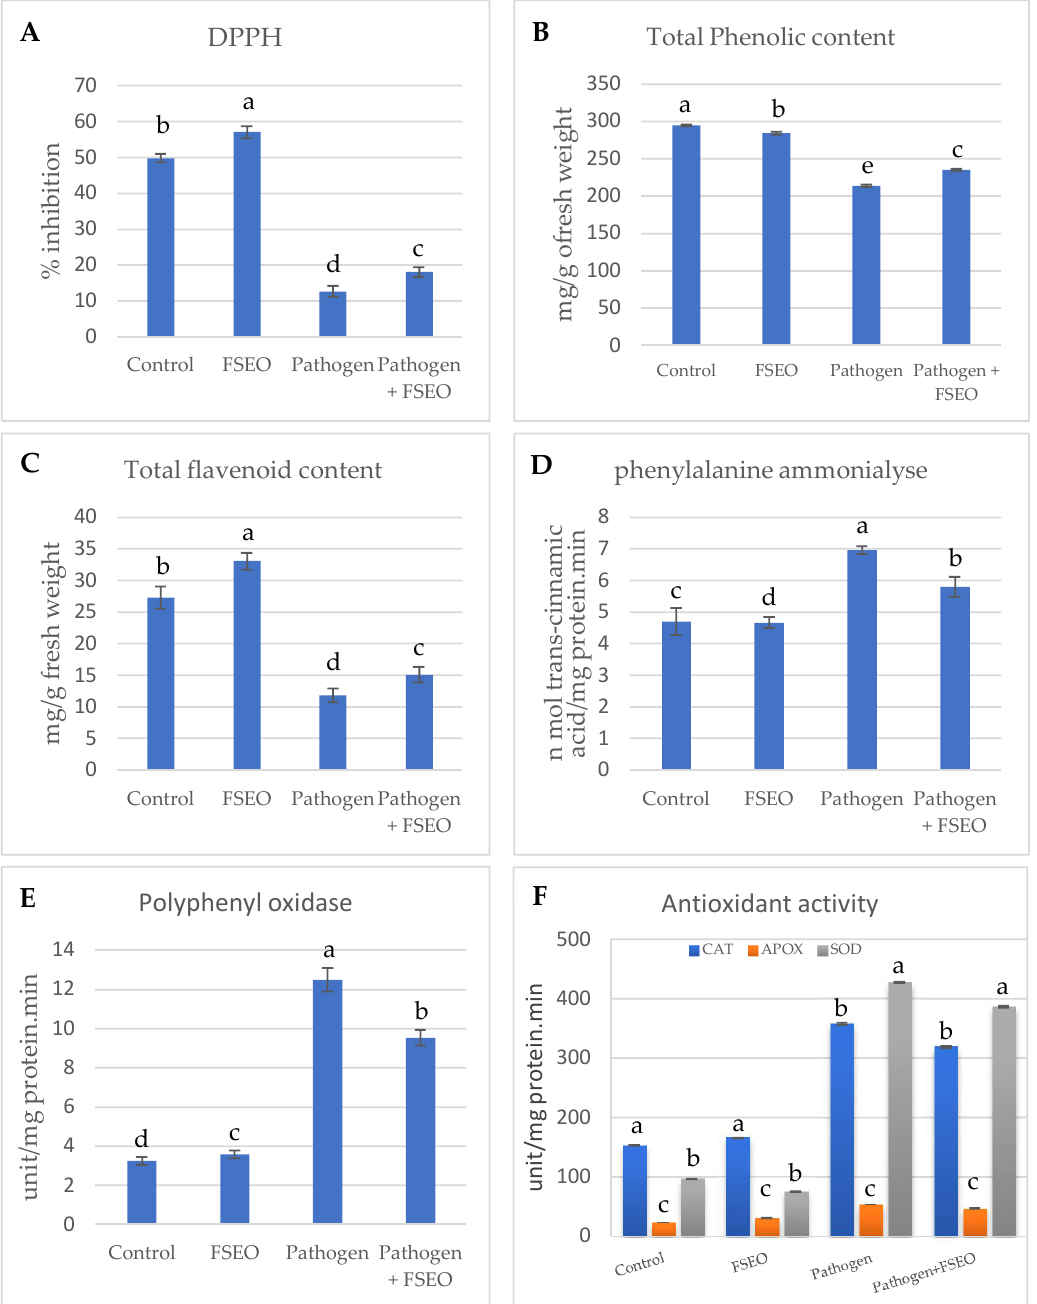
Figure 4. Biochemical components and antioxidant enzymes of plants, after 6 weeks of treatment. 2,2-Diphenyl-1-picrylhydrazyl (DPPH) radical scavenging activity ( A ), total phenol content (TPC) ( B ), total flavonoid content (TFC) ( C ), phenylalanine ammonia lyase (PAL) ( D ), polyphenol oxidase (PPO) ( E ) and antioxidant enzymes ( F ). Error bars indicate ± standard error of the mean of three replicates. Different alphabetic superscripts in the same column are significantly different ( p < 0.05) based on Tukey’s multiple comparison test.